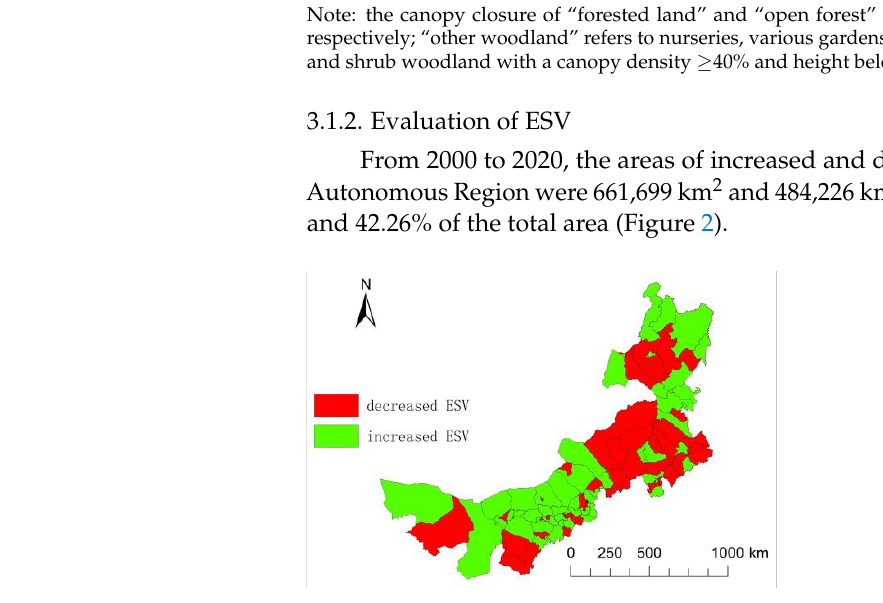
Figure 2. Spatial distribution of ESV changes in Inner Mongolia.